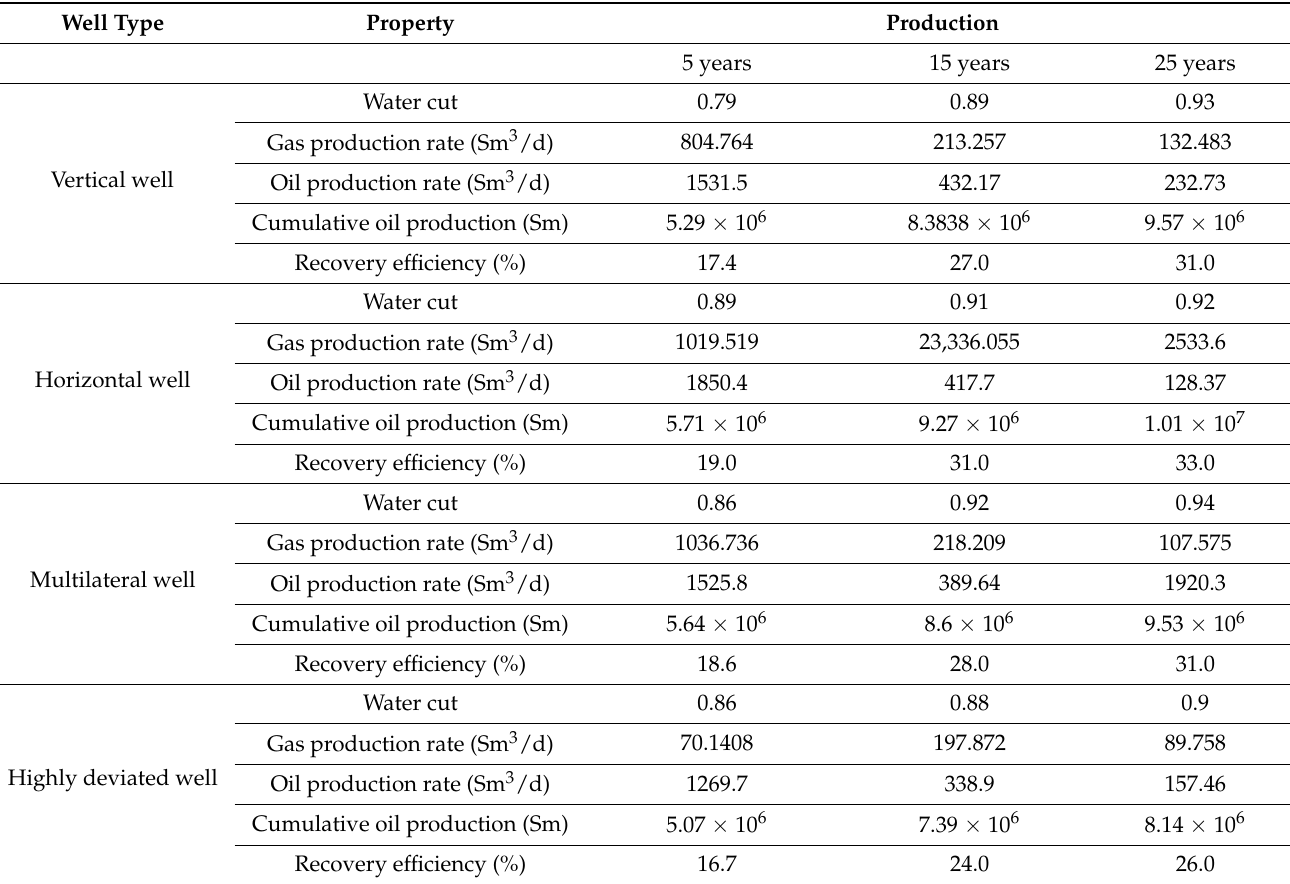
Table 8. Production performance of each well type by